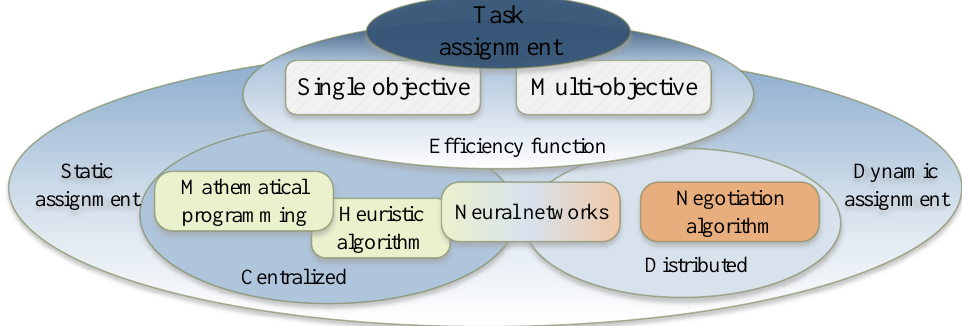
Figure 4. Classification of target assignment